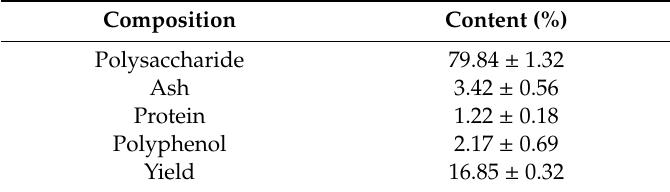
Table 1. Chemical composition of purified alginic acid from P.